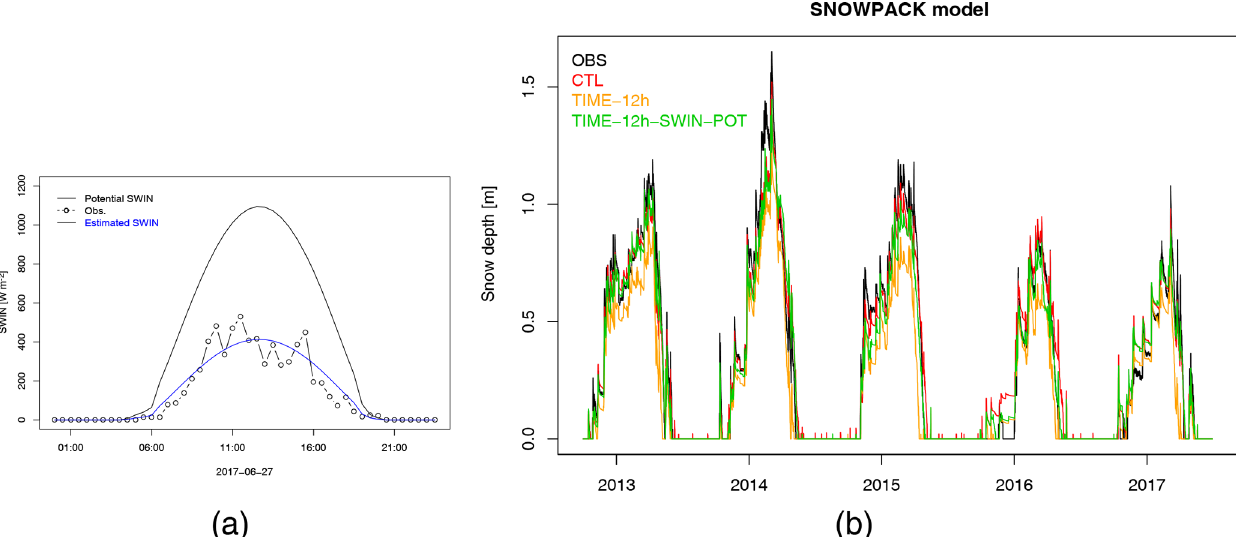
Figure C1. (a) Measured shortwave incoming radiation (SWIN) at the Torgnon site for the day 27 June 2017 (points), potential SWIN for that day (solid black line), and “estimated SWIN” from the scaling of the potential SWIN on the value registered at 12:00UTC + 1; (b) snow depth simulations obtained with the SNOWPACK model for experiment TIME-12h-SWIN-POT compared to TIME-12h-LIN, the CTL run, and